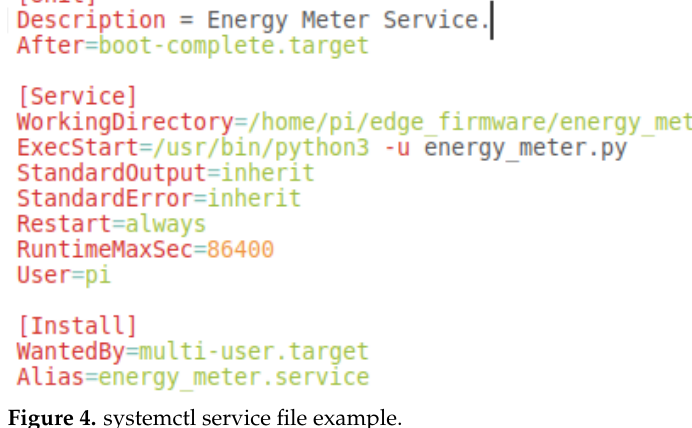
Figure 4. systemctl service file